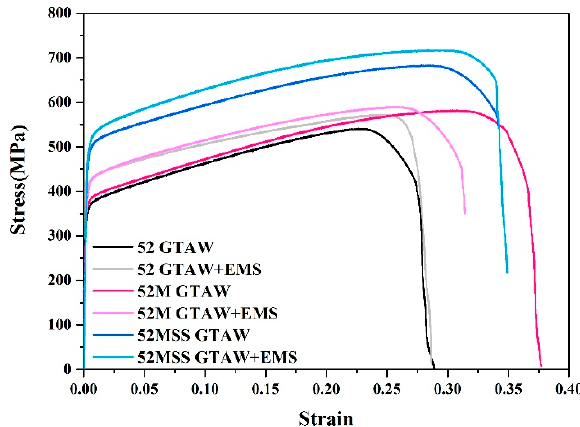
Figure 15. Tensile stress-strain curves for the welds tested at room temperature.